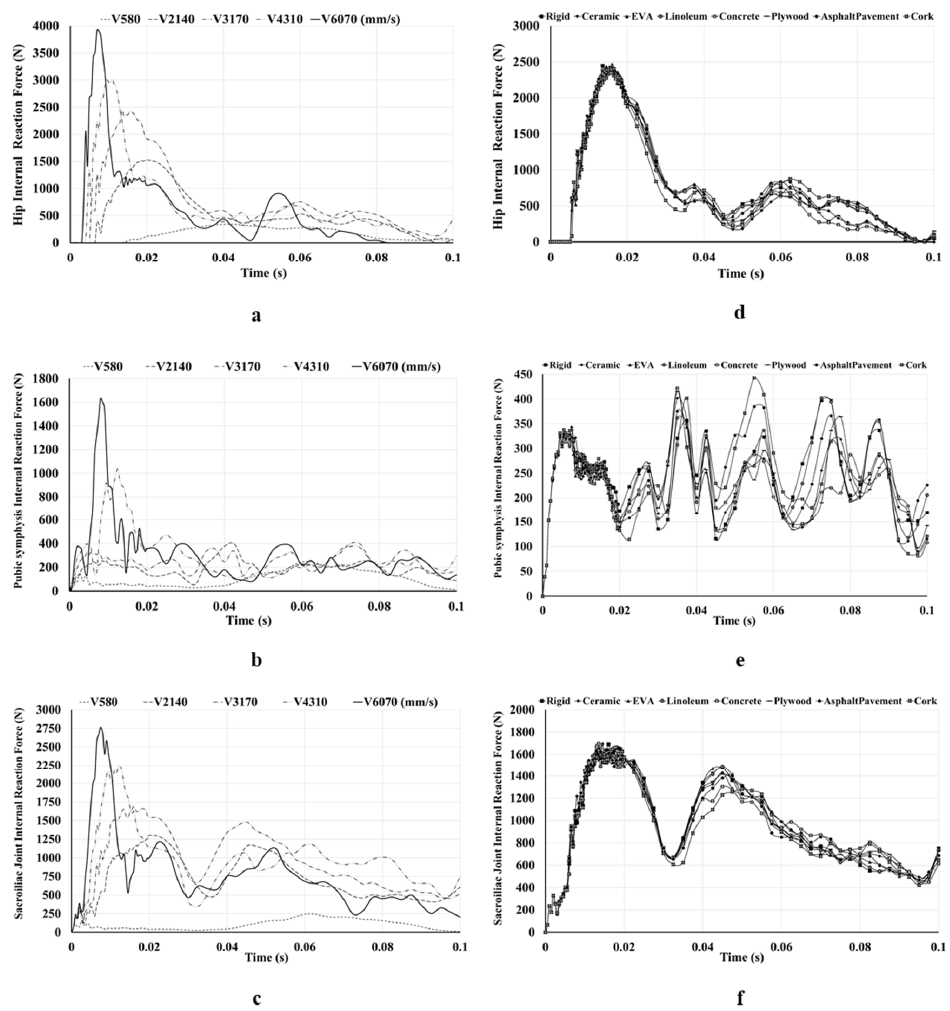
Figure 3. Internal reaction force: effect of ( a ) impact velocity at the hip; ( b ) impact velocity at the pubic symphysis; ( c ) impact velocity at the sacroiliac; ( d ) flooring material at the hip; ( e ) flooring material at the pubic symphysis; ( f ) flooring material at the sacroiliac joint.